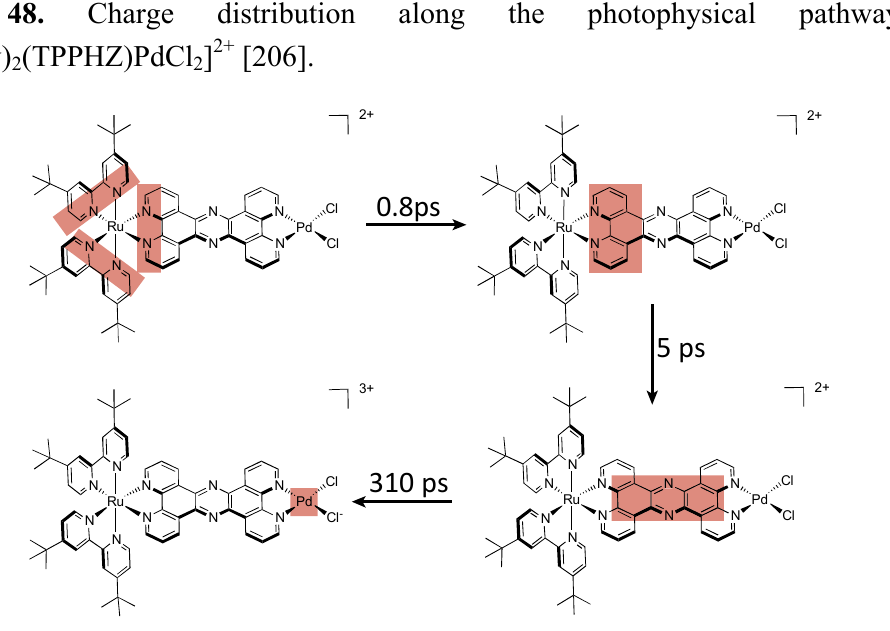
Figure 48. Charge distribution along the photophysical pathway for